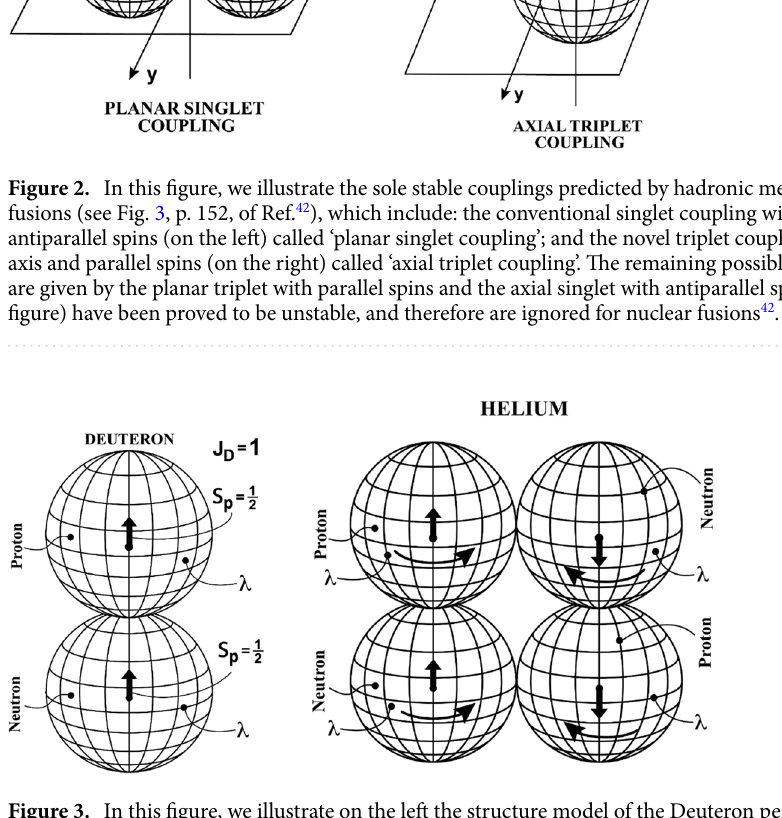
Figure 3. In this figure, we illustrate on the left the structure model of the Deuteron permitted by hadronic mechanics as a bound state under strong interactions of a proton and a neutron in ‘axial triplet coupling’ (Figure 2). This model has permitted the first known representation of the spin S d = 1 of the Deuteron in its true ground state (Section 8.2.5, p. 90 on of Refs. 15,31 ), here denoted 2 − H − 1 (cid:31) to indicate the presence of Bohm’s hidden variable in the spin of particles according to the iso-Pauli matrices of Eq. (18) 16 . In the right, we illustrate the structure model of the Helium, here denoted 4 − He − 2 (cid:31) , as a bound state under strong interactions of two nuclei 2 − H − 1 (cid:31) with antiparallel spins. This model allows a representation of the null spin and magnetic moment of Helium in its ground